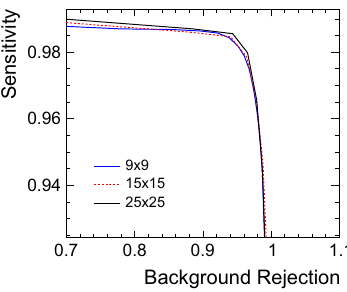
Fig. 9 ROC curves using different matrix sizes for the input data Fig. 10 ROC curves for different signal levels in the training